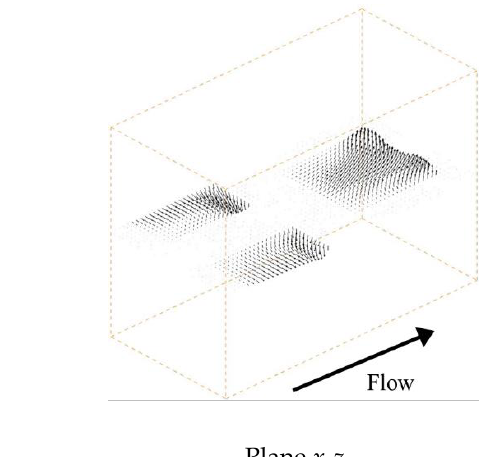
Figure 9. Velocity fields within Spacer 4. Since the structure is shifted vertically in the y and z directions to the main flow, the flow passing through the spacer is diverted in those directions by the structure.